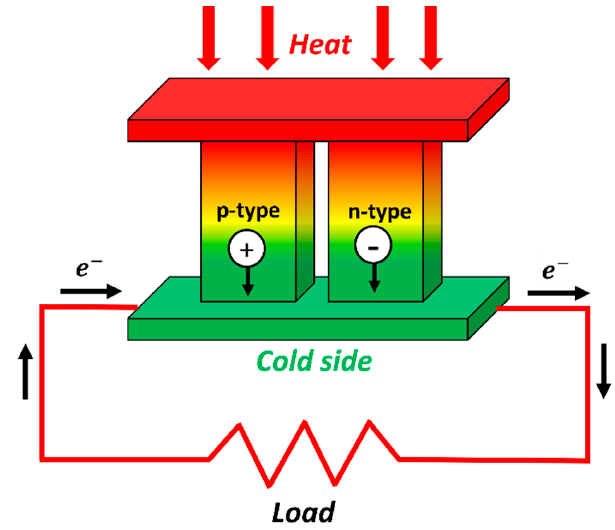
Figure 4. Physical principle of thermoelectric generator [35].